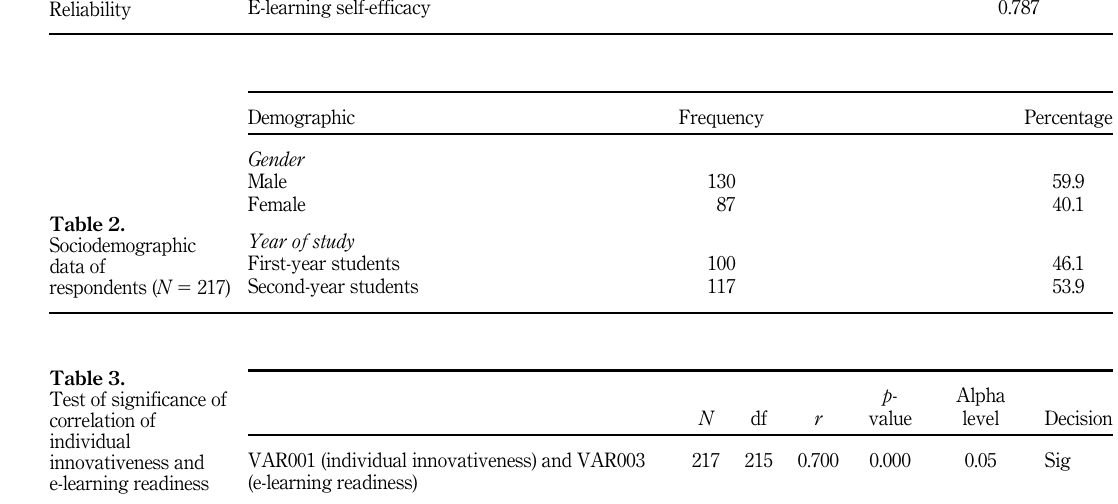
Table 1. Reliability